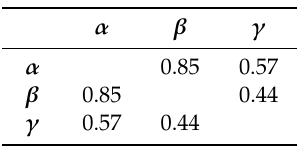
Table 3. Correlation matrix of the regression coe ffi cients of the exponential function using Spearman’s